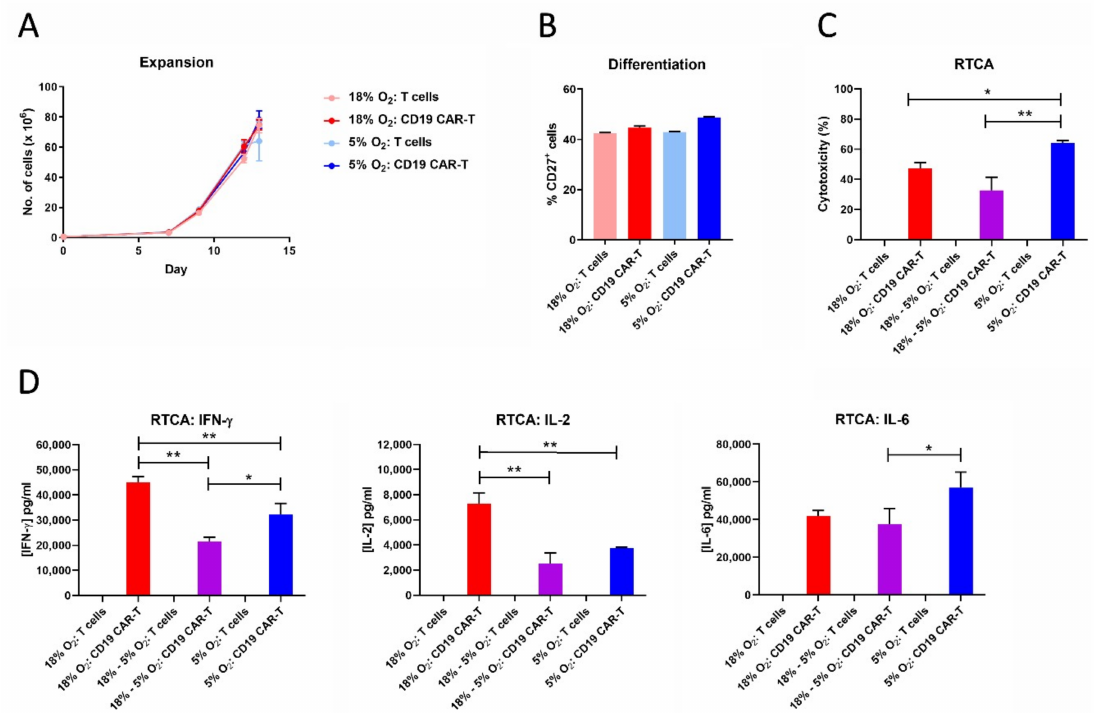
Figure 9. CAR-T cell expansion in 5% oxygen results in greater cytotoxicity and decreased IFN- γ / IL-2 production. CD19 CAR-T cells and control T cells expanded in 18% oxygen or 5% oxygen were analyzed for cell expansion ( A ), di ff erentiation ( B ), cytotoxicity ( C ), and cytokine production during the RTCA assay ( D ). Data points indicate averages of 2–3 replicates; * p < 0.05 and ** p <